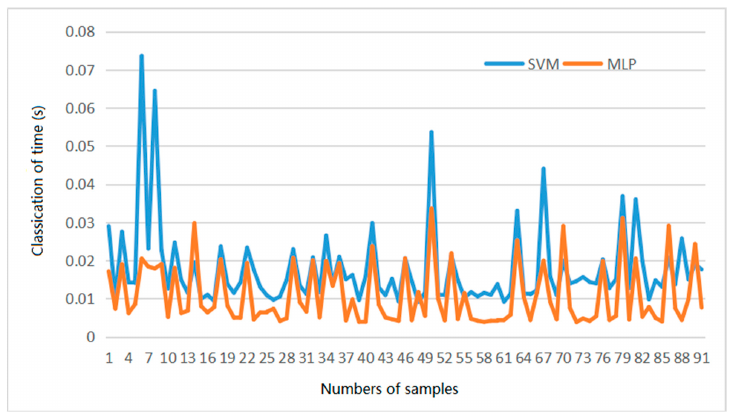
Figure 7. Classification time of MLP and SVM.